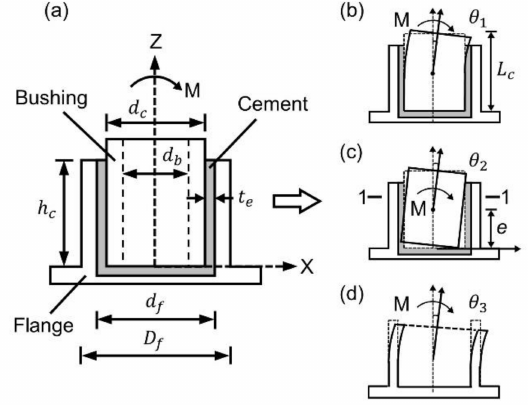
Figure 2. Joint connecting the porcelain bushing and flange. ( a ) Bending deformation of the flange and porcelain bushing connecting joint; ( b ) Porcelain bushing bending deformation; ( c ) Cement mortar extrusion deformation; ( d ) Flange member ring wall bending